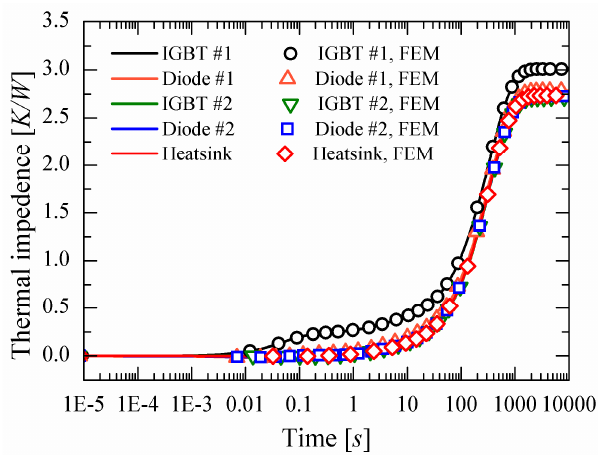
Figure 3. Comparison between standard FEM and DCTM self and mutual thermal impedances, obtained by applying a unit power step on IGBT #1 with a 2.5 K/W